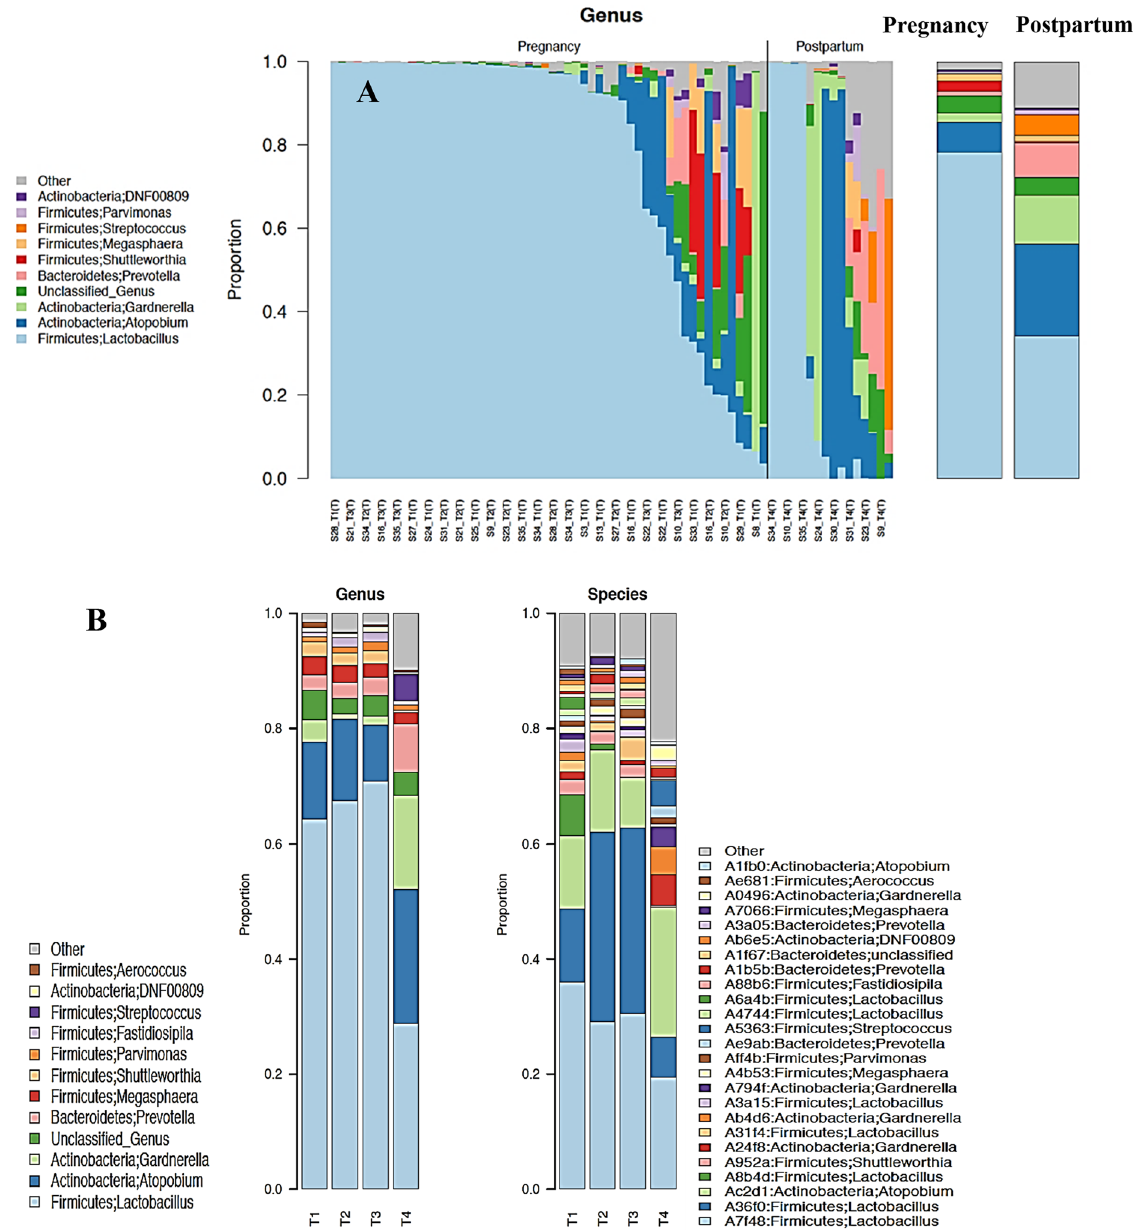
Figure 4. Vaginal Profile and taxa abundance analysis across pregnancy and postpartum vaginal samples. (A) Stacked bar plots of average relative abundance at genus taxonomic level compared across pregnancy and postpartum vaginal samples. Vaginal profile of pregnant women were Lactobacillus dominated compared to postpartum vaginal samples with a high proportion of abnormal vagitypes including unidentified bacteria, Prevetolla , Streptococcus , Gardnerella , and Atopobium . (B) Stacked bar plots of average relative abundance at genus taxonomic level compared according to gestational age of delivery and postpartum. With increasing gestational age, pregnant women were also more likely to steadily maintain a Lactobacilli profile, this however changed at the postpartum to become less dominated by Lactobacillus and more dominated by community state type IV both at genus and specie level. (C) Tukey boxplots show differences in relative abundance at phylum, family and genus level across pregnancy and postpartum samples. Firmicutes, Lactobaccillaceae, and Lactobacillus dominate the pregnancy vaginal samples compared to the postpartum samples dominated by Bacterial vaginosis associated